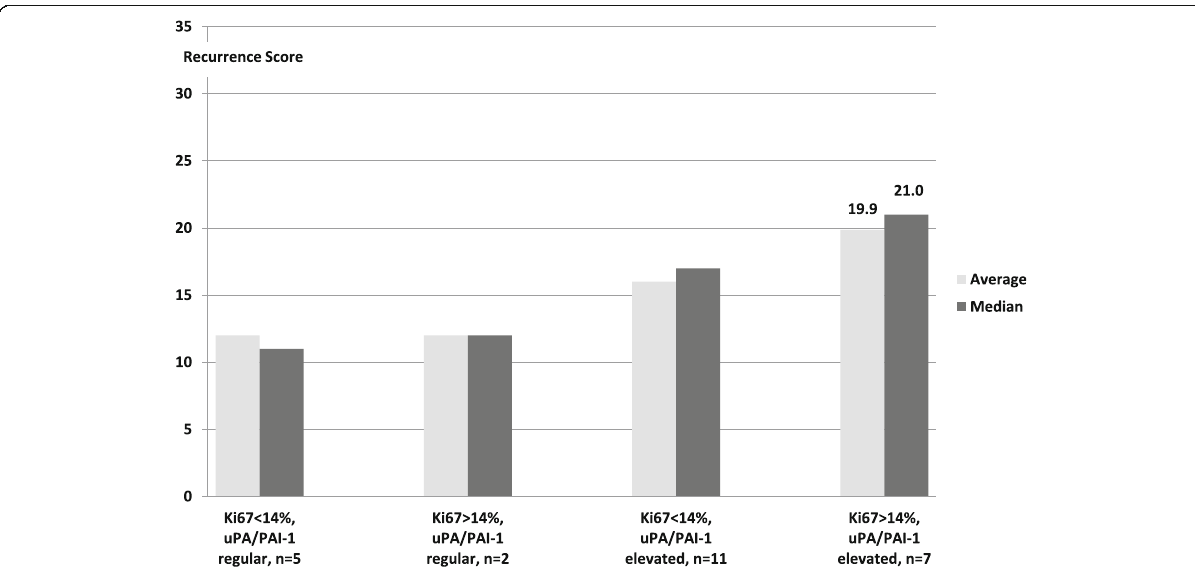
Fig. 2 Average and median recurrence scores (RS) of OncotypeDX® depends from results in immunohistochemial measurement of Ki67-index and protein levels of uPA/PAI-1 (Ki67 < 14% and uPA/PAI-1 regular to Ki67 > 14% and uPA/PAI-1 elevated p <